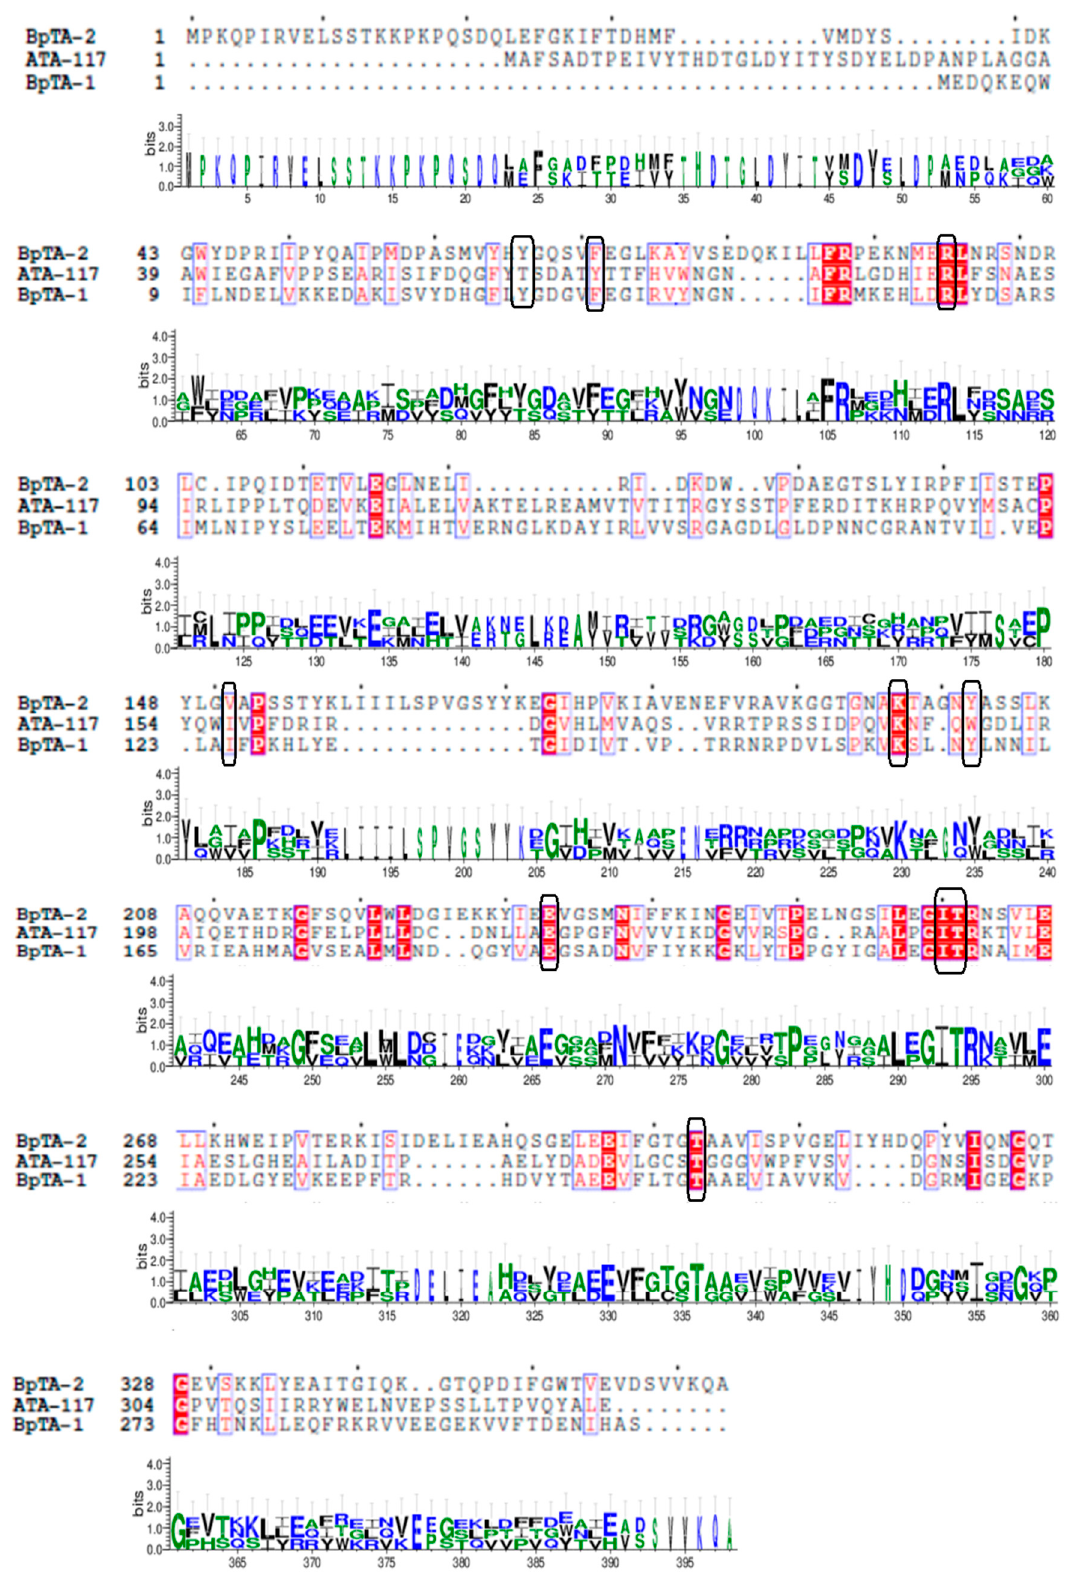
Figure 1. Amino acid sequence alignment of the transaminase BpTA-2, BpTA-1 and ATA-117. The amino acid residues in the black box are the active site residues of these three enzymes.